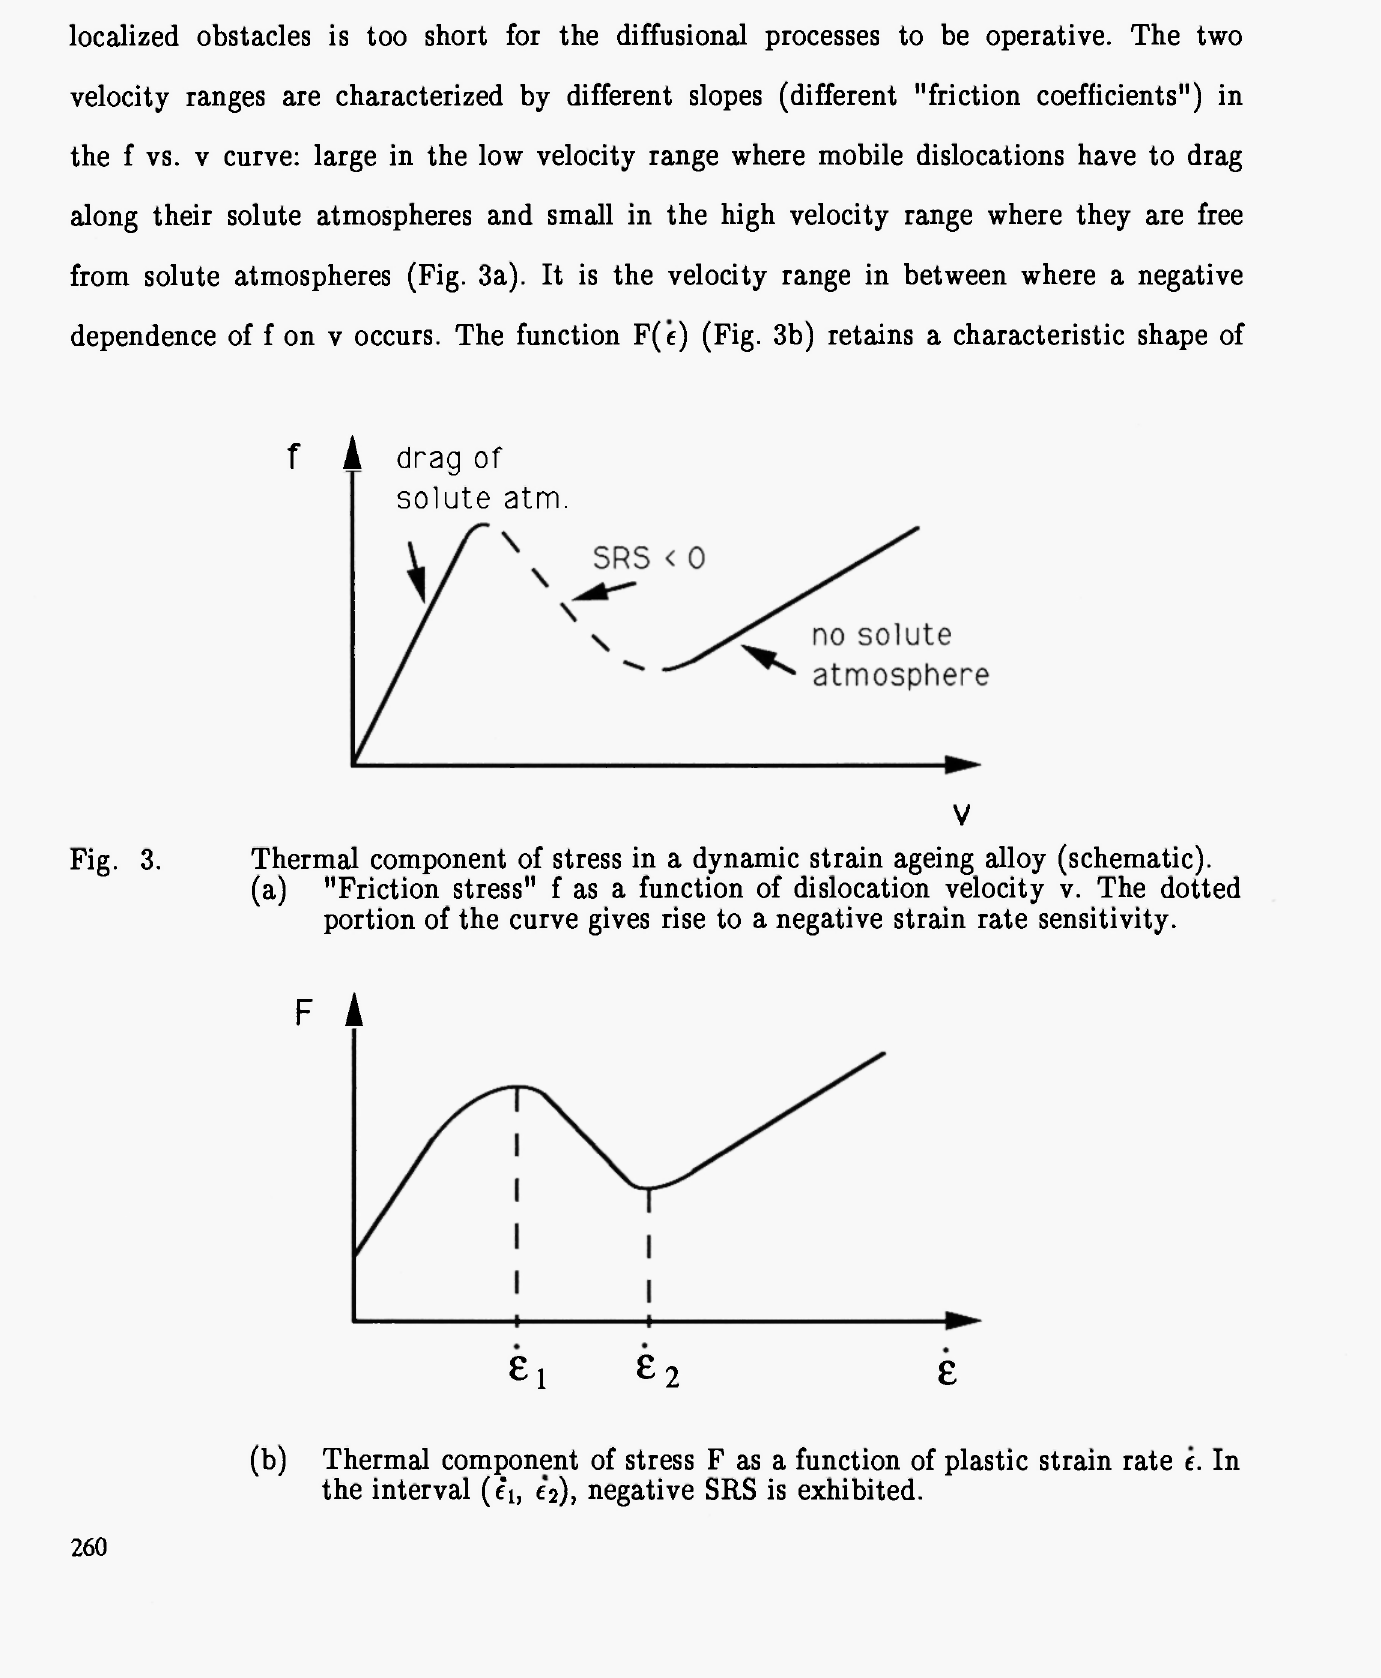
Thermal component of stress F as a function of plastic strain rate e. In the interval (e"i, 62), negative SRS is